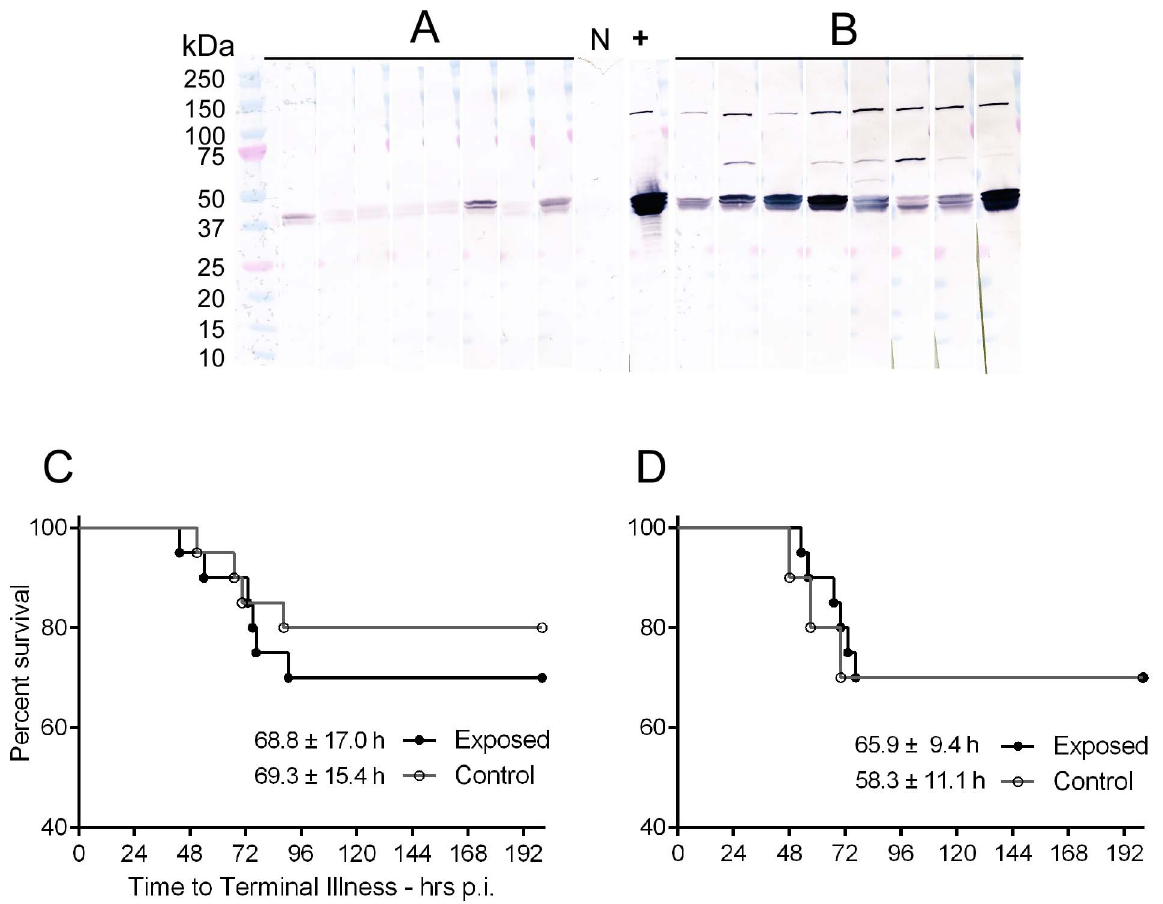
Figure 7. Previous exposure to uninfected flea bites does not affect the incidence or progression of bubonic plague in mice challenged by infective (blocked) fleas. Immunoblots showing IgG responses to X. cheopis salivary gland extract of 8 representative individuals from each of the low-exposure ( A , 25 fleas once per week for 5 weeks) and high-exposure ( B , 25 fleas twice per week for 10 weeks) group (see Table 1). Molecular weights (kDa) of protein standards are indicated at left; bracket at right indicates the position of the 36–45 kDa phosphatase-like SGE proteins. Sera were used at a dilution of 1:250, negative control serum from an unexposed C57BL/6 mouse at 1:250; + , positive control mouse serum at 1:10K. The incidence and time to development of terminal plague in mice challenged with Y. pestis -blocked fleas after low- ( C ) or high-level ( D ) prior exposure to uninfected fleas were not significantly different from naive mouse controls. Inset numbers indicate time to terminal disease in hours (mean 6